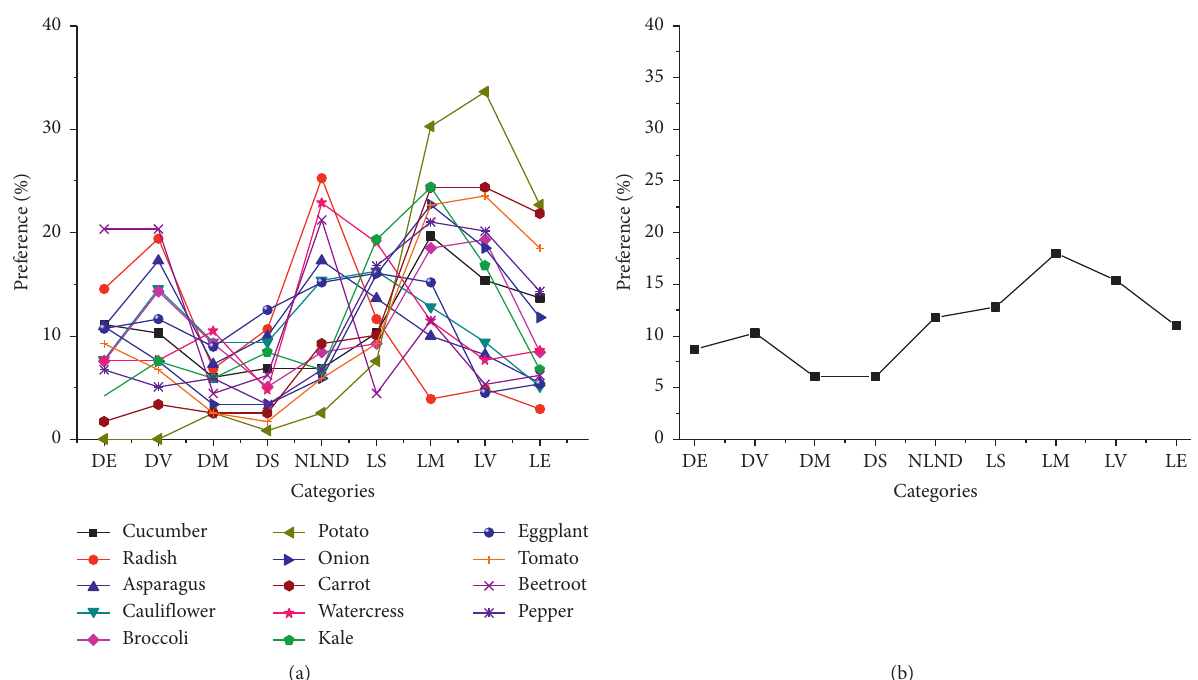
Figure 8: Food preference results. (a) Each vegetables group food. (b) Vegetables group as a